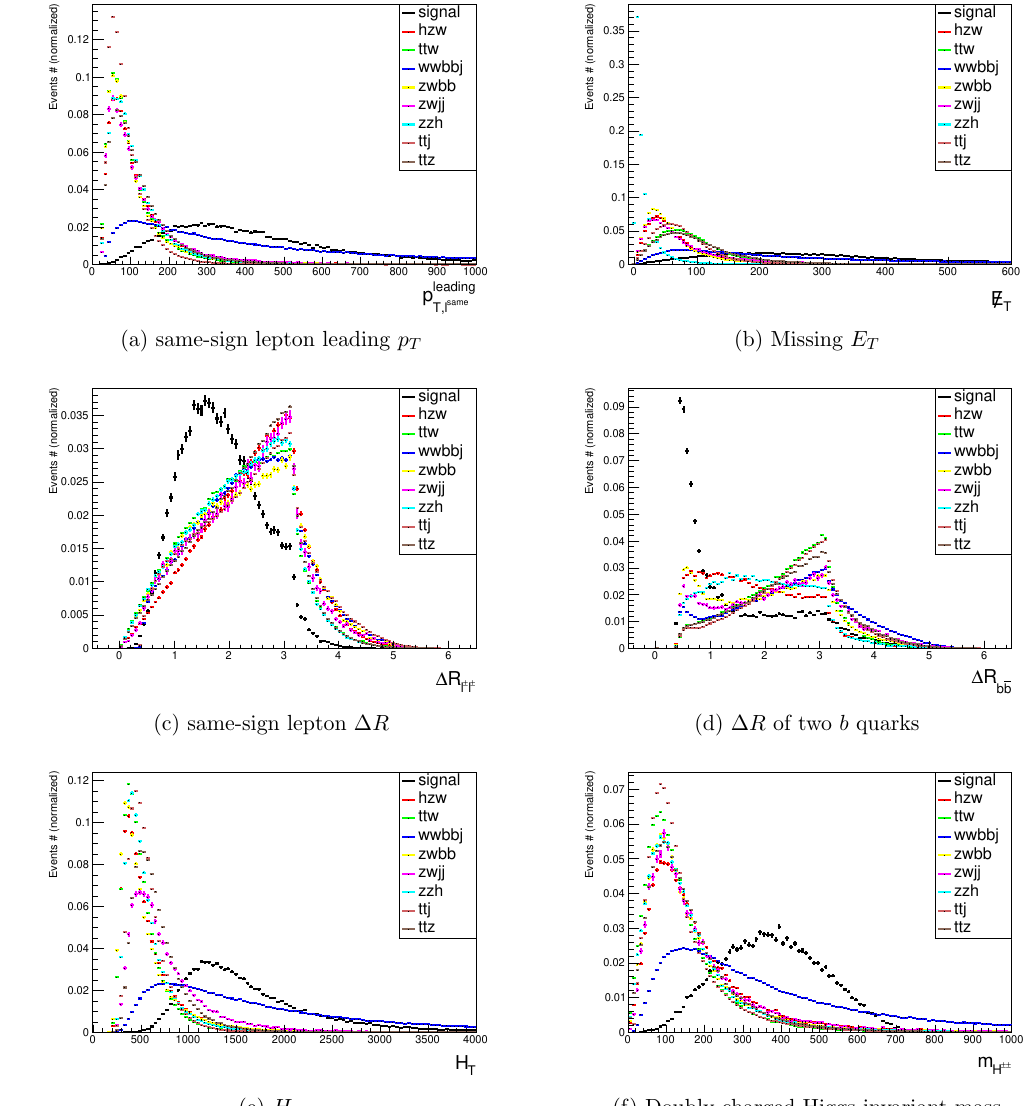
Figure 10 . Reconstructed variables for the W (cid:6) W (cid:6) hW (cid:7) channel under basic cuts. We use the word \signal" to represent the pp ! H (cid:6)(cid:6) H (cid:7) ! W (cid:6) W (cid:6) hW (cid:7) channel in all histograms